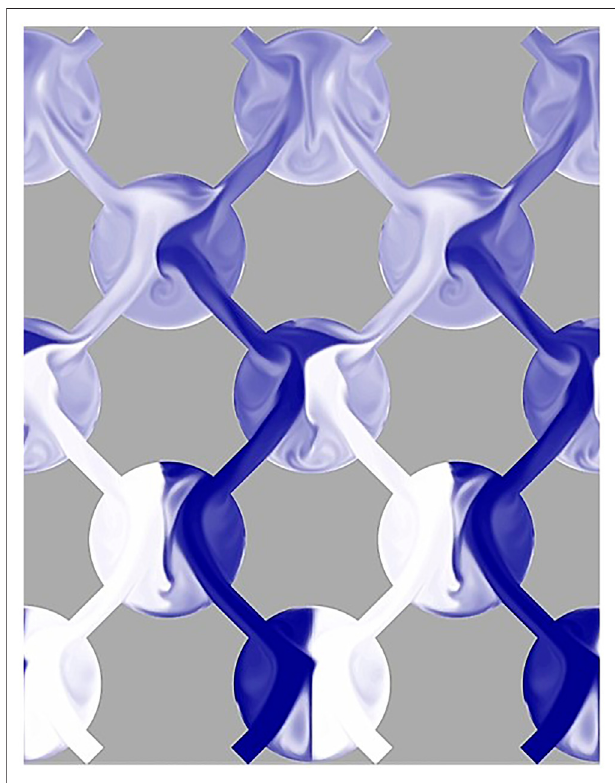
FIGURE 1 | Passive tracer concentration map: NETmix network and fl ow pattern (Fonte et al., 2013).